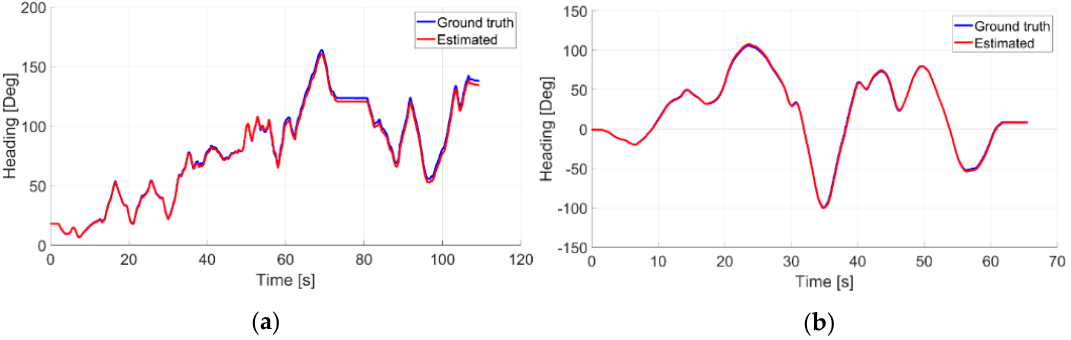
Figure 13. Angular estimations (in red) for the ( a ) experiment I and ( b ) the experiment II together with the respective ground truth ones (in blue).